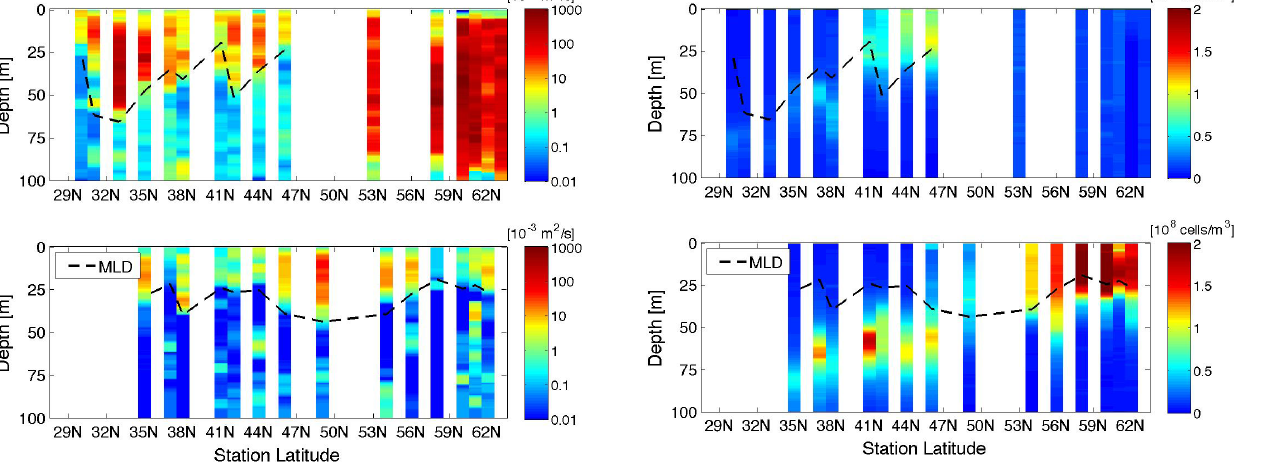
Figure 2. Interpolated and smoothed vertical mixing coefficient in spring (top) and summer (bottom) along the transect in Fig. 1a. The dashed curve indicates the MLD.